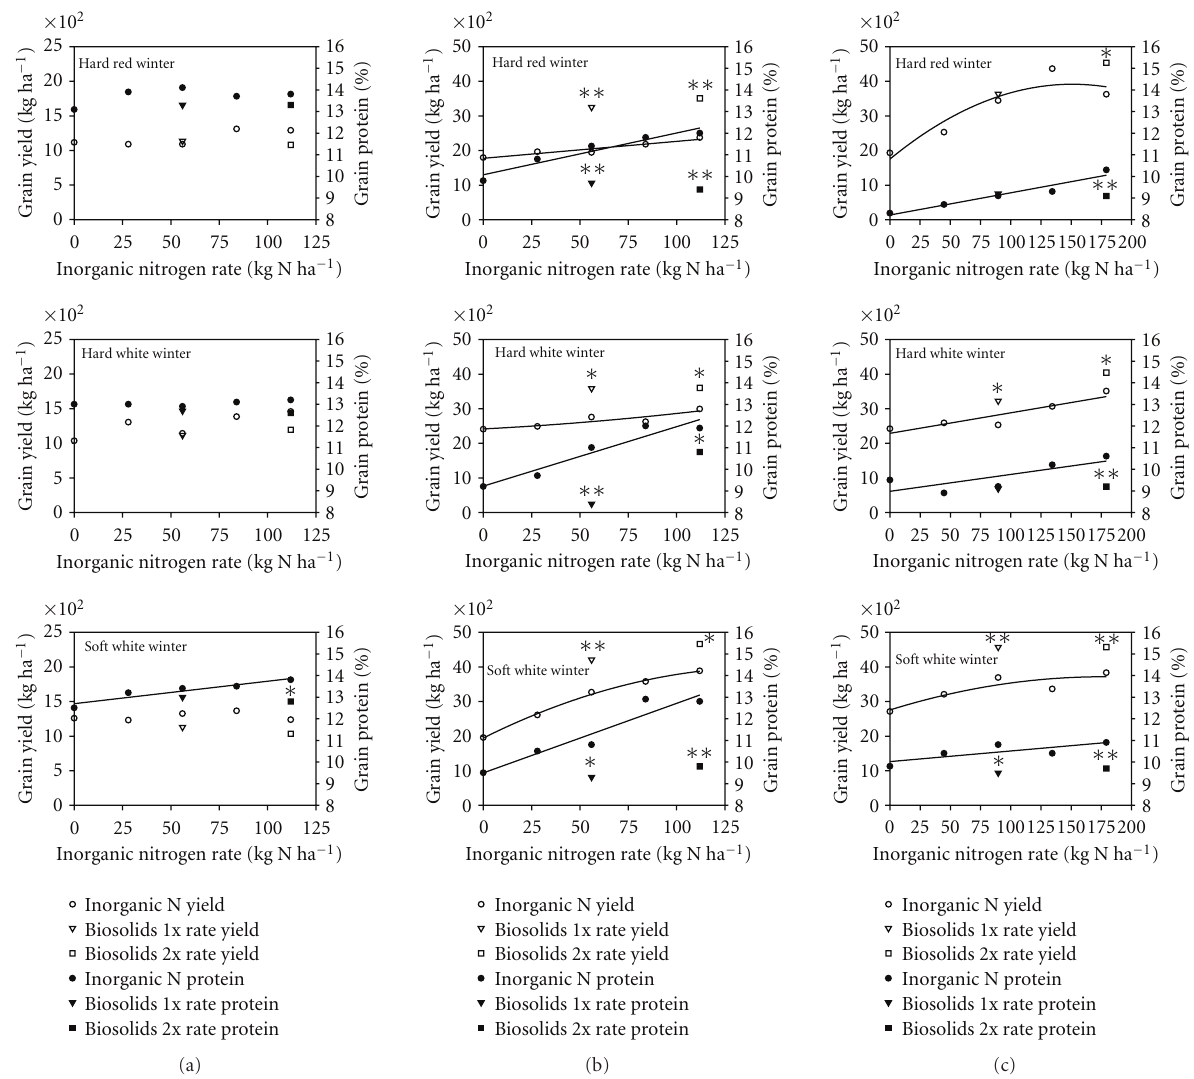
Figure 2: The e ff ect of inorganic N fertilizer and biosolids on yield and grain protein content of three wheat market classes at Lind (a), Davenport (b), and Pullman (c), Wash in 2008. The horizontal axis (N rate) is the same for Lind and Davenport but higher for Pullman. Due to di ff erences in grain yield, the vertical axis is di ff erent for Lind relative to Davenport and Pullman. Where indicated by the regression line, quadratic or linear responses are significant at P < . 05. If no regression line is included the relationship was not significant ( P > . 05). ∗ and ∗∗ indicate significant di ff erences at the 0.10 and 0.05 level, respectively, between inorganic N and biosolids treatments at that inorganic nitrogen and biosolids